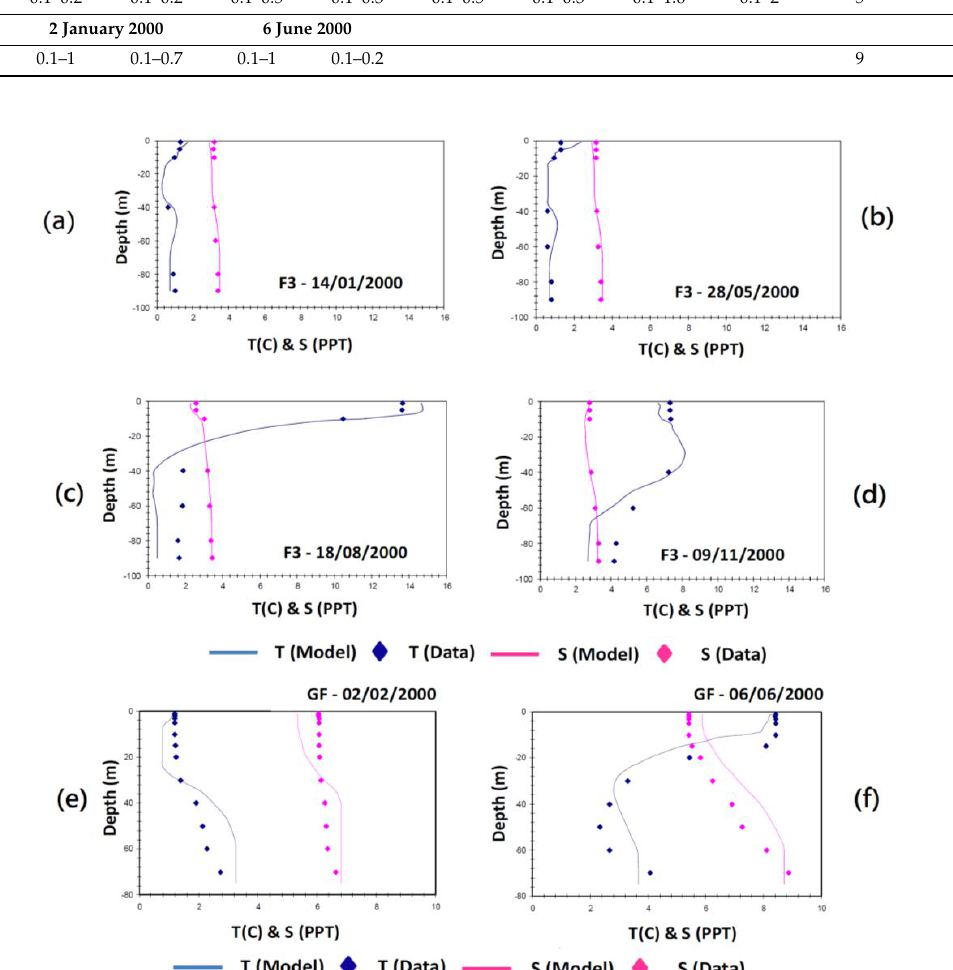
Figure 5. Comparison of model predicted vertical temperature and salinity profiles at the monitoring stations F3 (Bay of Bothnia) and GF (Gulf of Finland) with field measurements for the year 2000. ( a ) Station F3—14/01/2000; ( b ) Station F3—28/05/2000; ( c ) Station F3—18/08/2000; ( d ) Station F3—09/11/2000; ( e ) Station GF—02/02/2000; Station ( f )—06/06/2000.